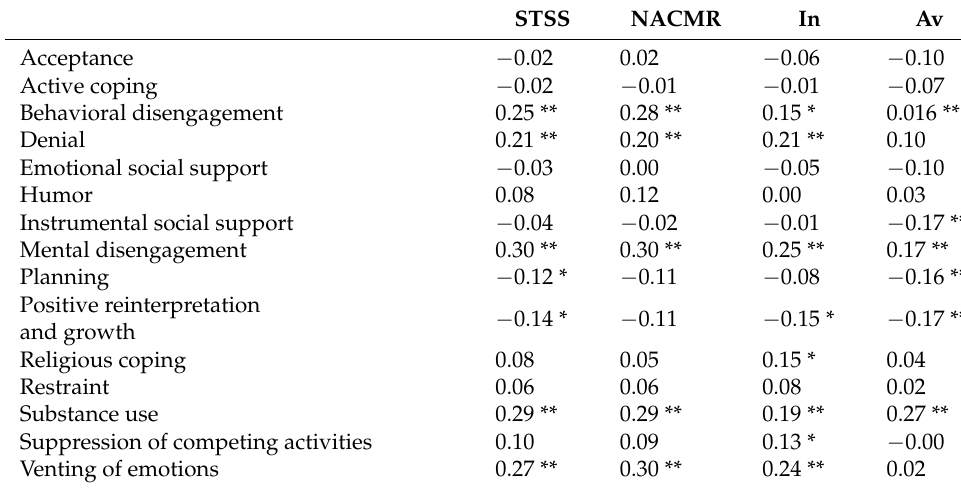
Table 2. Correlations between coping mechanisms and secondary traumatic